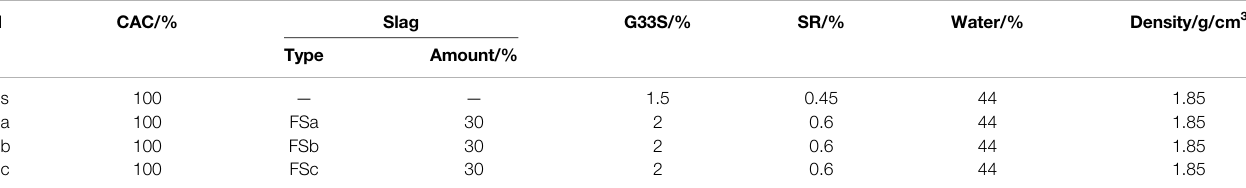
TABLE 2 | Cement slurry formula.